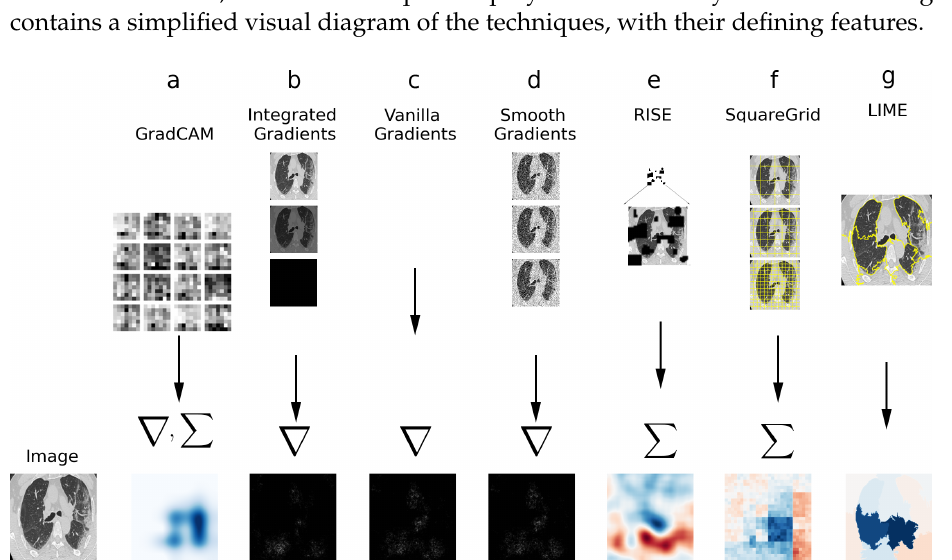
Figure 2. Visual diagram of XAI techniques used in this study. ( a ) GradCAM: gradients to the last convolution are computed and weighted sum is calculated. ( b ) Integrated Gradients: Sum/integral based on interpolations of the image. ( c ) Vanilla Gradients: Direct gradient computation. ( d ) Smooth Gradients: gradient computation on noisy versions of the image. ( e ) RISE: weighted sum of perturba- tion masks. ( f ) Squaregrid: perturbations using square grid divisions. ( g ) LIME: perturbations using superpixels computed via